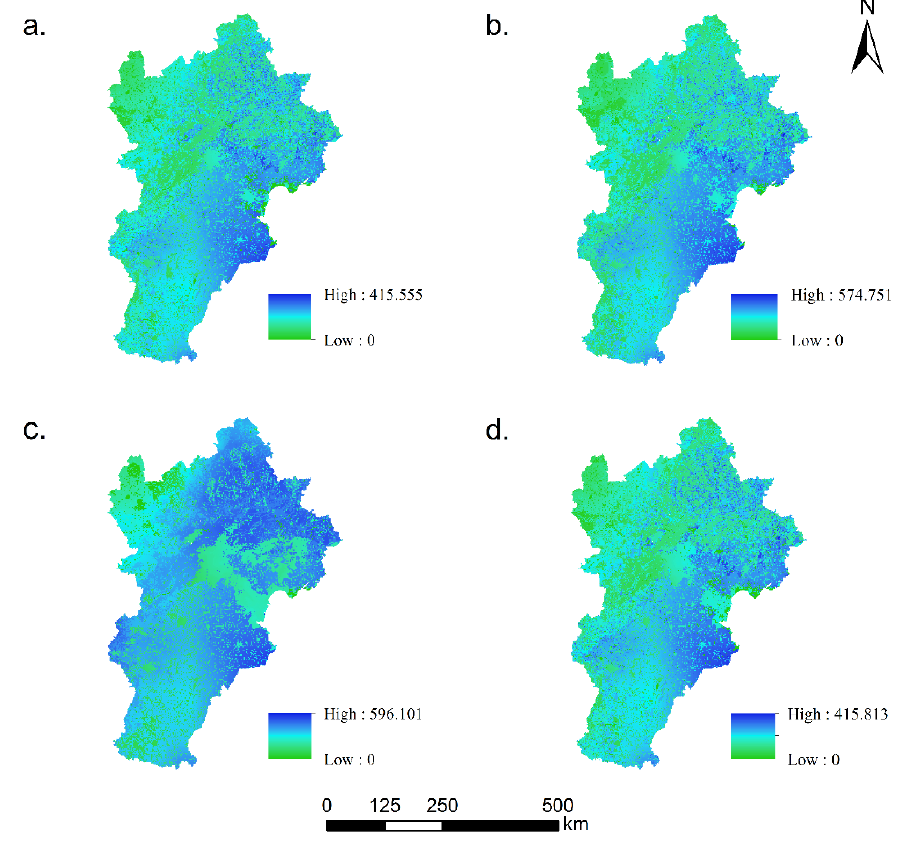
Figure 3. Distribution of water yield under different scenarios. ( a ) 2015; ( b ) conservation scenario; ( c ) development scenario; ( d ) natural scenario).